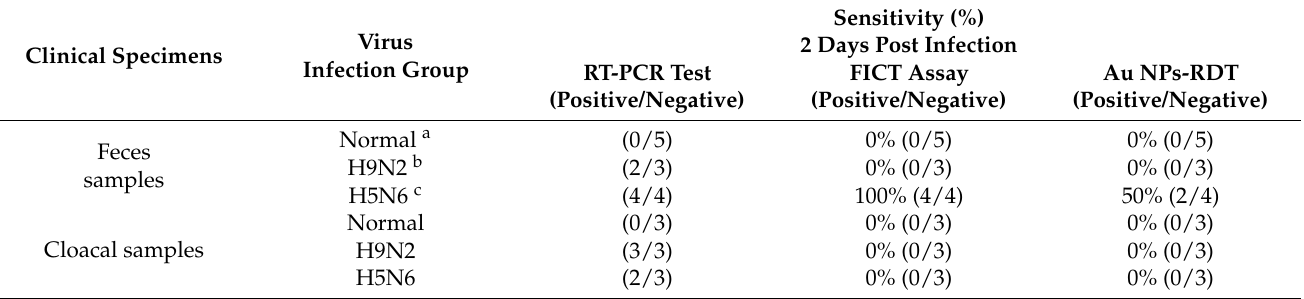
Table 1. Comparison of FICT, colloidal gold-RDT, and RT-PCR assays diagnostic performance on clinical